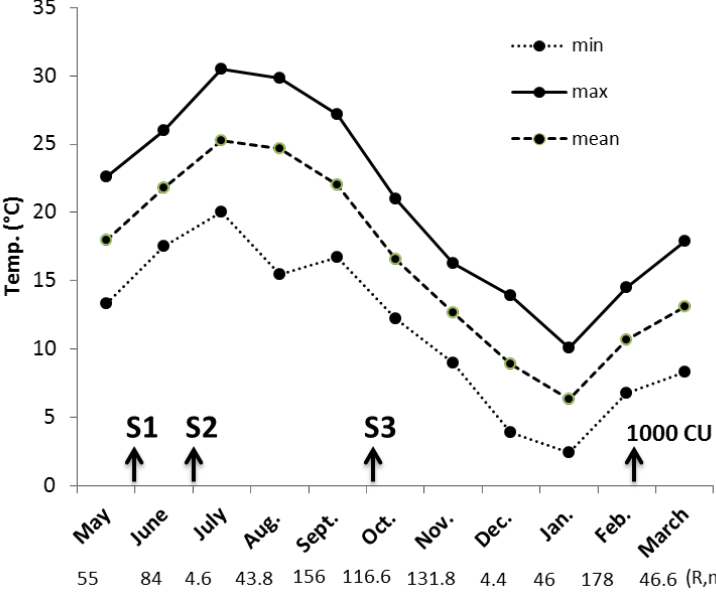
Figure 2. Monthly minimum, maximum and mean average temperatures (°C) from the month before starting experimental trials (May 2016) up to March (2017). Arrows indicate the drought treatments S1, S2 and S3 (30 d long followed by re-watering) and the chilling units (CU) accumulated at the end of flower bud endodormancy break. Below the abscissa axis, monthly amounts of rainfall (R, mm) are shown.